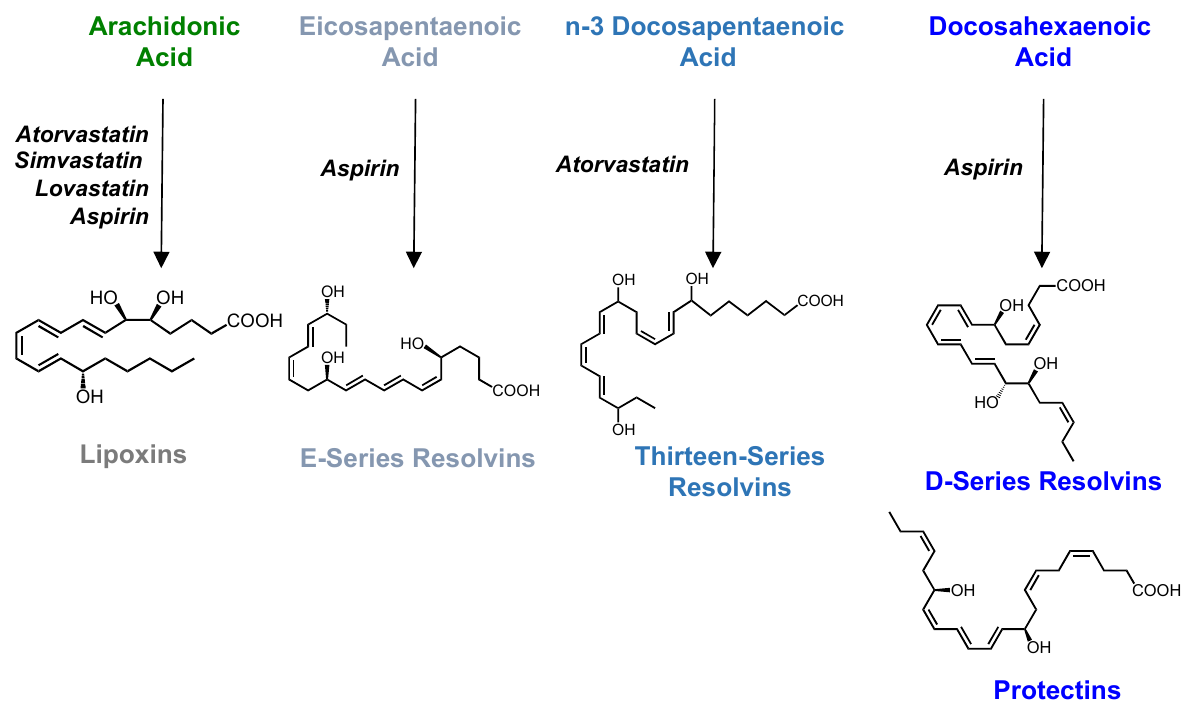
Figure 3. Specialized pro-resolving mediators mediate the protective activities of statins and aspirin. Mounting evidence suggests that SPM are central in mediating the protective activates of widely used drugs such as statins and aspirin. This figure provides a summary of the lipid mediator families that have been shown to mediate the anti-inflammatory activities of specific drugs.